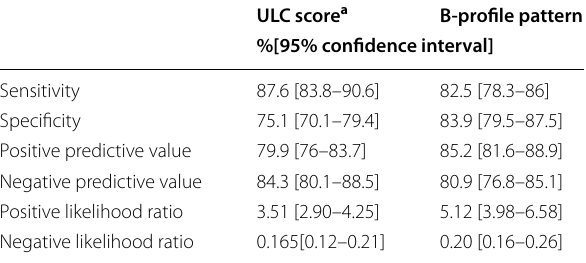
Table 2 Ultrasound lung comets (ULC) score and B-profile pattern accuracy